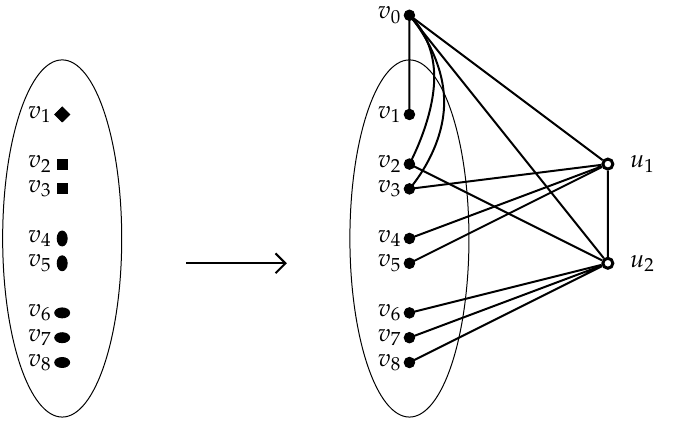
Figure 19. A constrained point-line graph G with eight constrained line vertices: v 1 has a fixed normal; v 2 and v 3 are fixed;